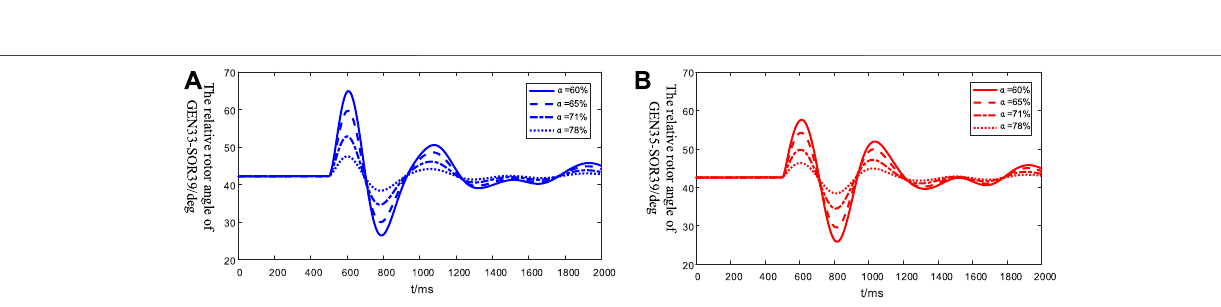
FIGURE13| Therelative anglecurve ofconstanttotaltransmissionpower (A) Relativeangle curveofGEN33-SOR-39and GEN35-SOR39 at α (cid:2) 60% (B) Relative angle curve of GEN33-SOR-39 and GEN35-SOR39 at α (cid:2) 65% (C) Relative angle curve of GEN33-SOR-39 and GEN35-SOR39 at α (cid:2) 71% (D) Relative angle curve of GEN33-SOR-39 and GEN35-SOR39 at α (cid:2) 78%.